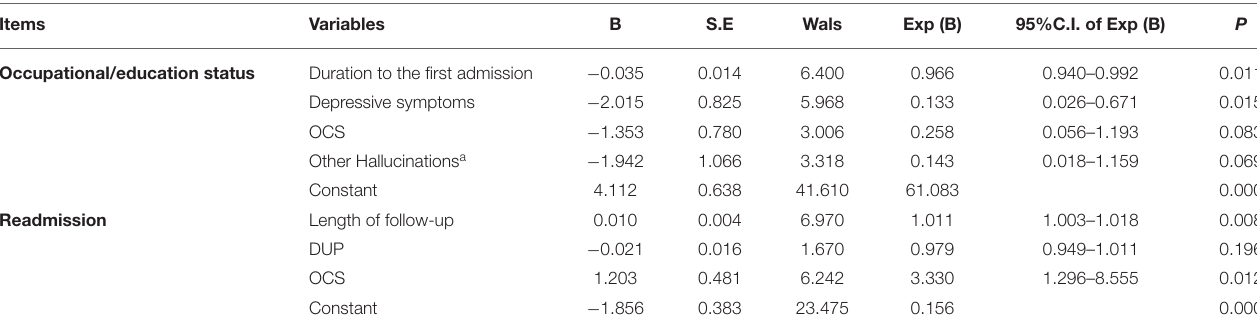
TABLE 6 | Binary logistic regression analyses of COS